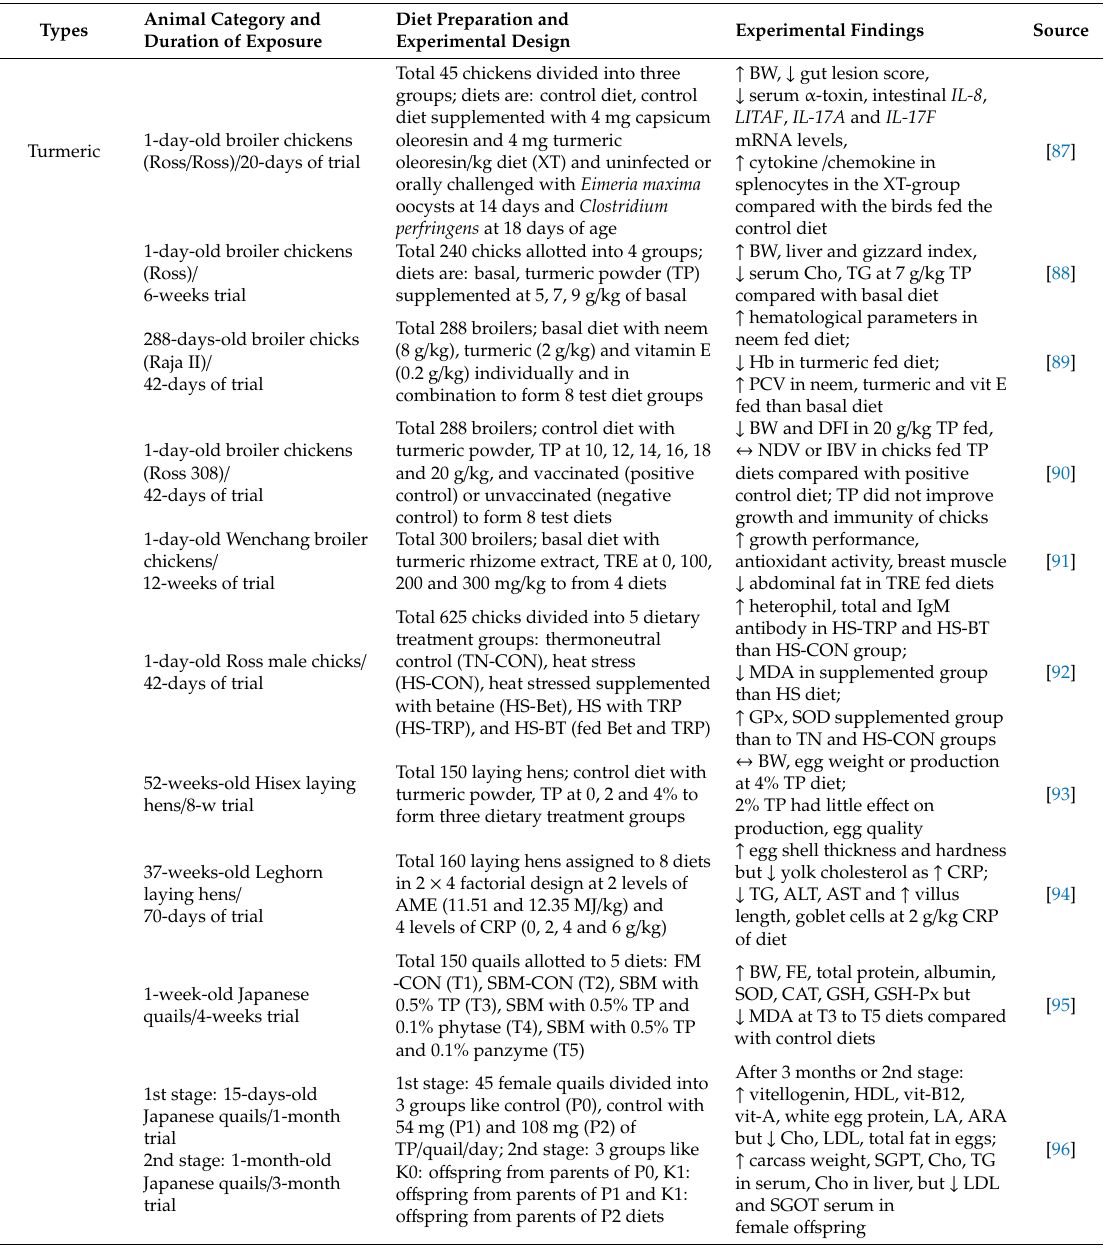
Table 2. E ff ects of dietary turmeric, curcumin and nanocurcumin in poultry